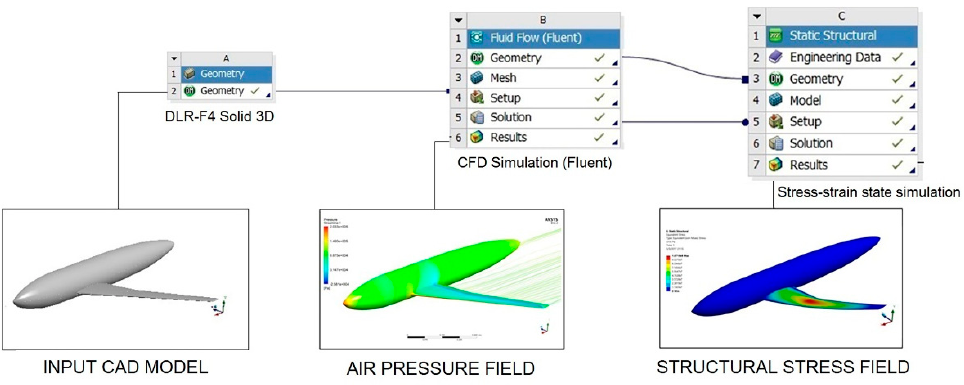
Figure 1. Data exchange scheme about DLR-F4 simulated model between the geometry, gas dynamics and structural stress modules inside ANSYS Workbench environment.